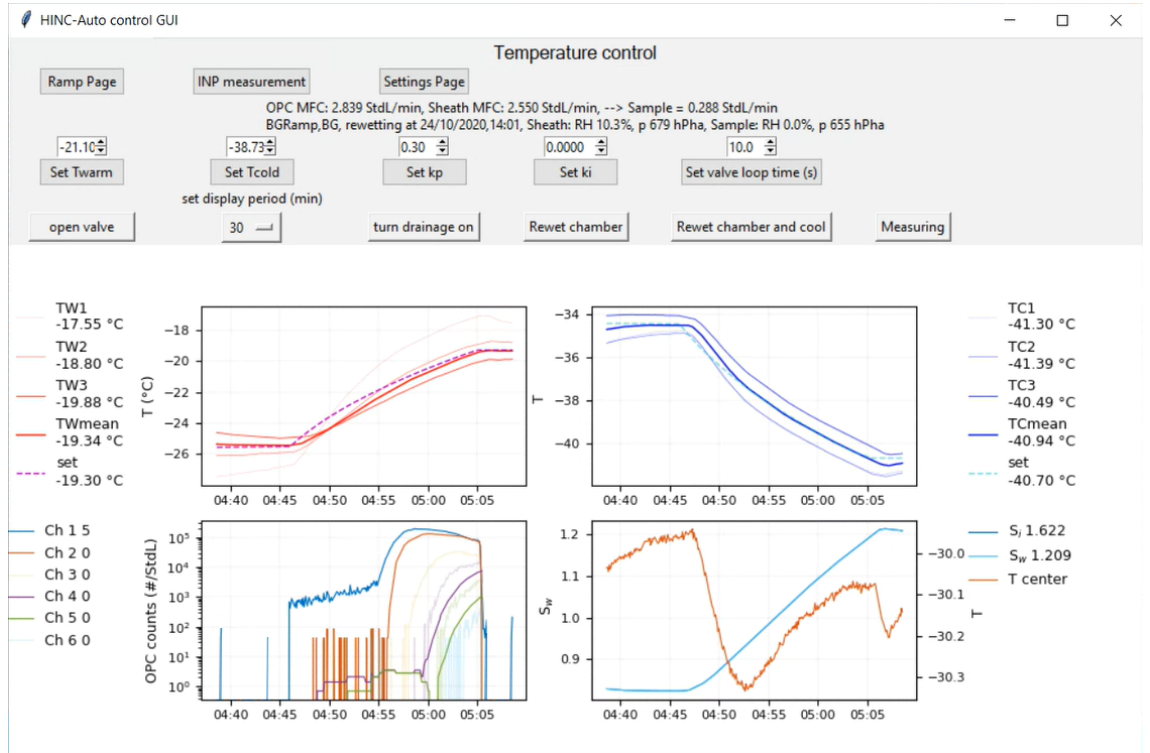
Figure A8. Main window of the guided user interface used to control HINC-Auto. Top row buttons: Ramp Page leads to the window to run S w or T ramps (see Fig. A9), INP measurement leads to the window to run INP measurements (see Fig. A10), and Settings Page leads to the window to change additional settings (see Fig. A11). OPC MFC shows the current flow rate of the OPC MFC, as reported by the MFC, Sheath MFC analogously shows the flow rate of the sheath flow MFC, and Sample reports the difference between both MFC, which corresponds to the current sample flow rate. BGRamp shows the target state of the chamber, in this case “measuring the background after or before a RH or T ramp”, BG shows the current state of the chamber, rewetting at indicates the time of the next planned re-wetting procedure (UTC), Sheath indicates the RH and pressure p of the sheath air as it enters the chamber (measured at mid-height within the chamber upstream of the mesh and thus at the same temperature as the chamber is set to), and Sample indicates the RH and pressure p of the sample air (just downstream of the sample diffusion dryer). Center row buttons: Set Twarm sets the target temperature of the warm wall, Set Tcold sets the target temperature of the cold wall, Set kp and Set ki set the proportional gain ( k p ) and integral gain ( k i ) of the PI controller to control the warm wall temperature, and Set valve loop time (s) defines the duration of a loop to actuate the warm wall solenoid valve. Bottom row buttons: open valve manually opens and closes the warm wall solenoid valve, Set display period (min) defines the amount of historic data to be shown in the four graphs below, turn drainage on manually actuates the pump to drain the chamber during re-wetting, Rewet chamber executes the re-wetting procedure, Rewet chamber and cool executes the re-wetting procedure and cools the chamber back down to the set temperature of the chamber before the button was activated, and Measuring changes the chamber’s state and valves to sampling or background measurement. The top left graph shows the warm wall temperature (all three thermocouples, the computed mean wall temperature and the set temperature). The top right graph shows the cold wall temperature (all three thermocouples, the computed mean wall temperature and the set temperature). The bottom left graph shows the counts reported by the OPC for each of the six size bins (here, size bin 1 (CH 1) is set to ≥ 0.3µm, CH 2 set to ≥ 1µm, CH 3 set to ≥ 3µm, CH 4 set to ≥ 4µm, CH 5 set to ≥ 5µm, and CH 6 set to ≥ 6µm). The bottom right graph shows S w and T for the center lamina